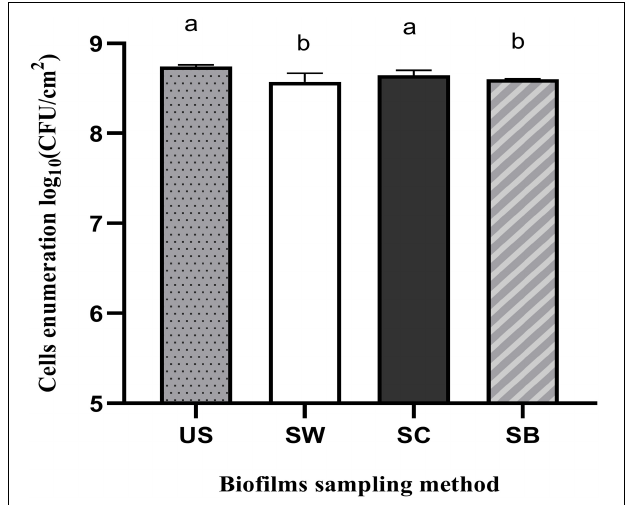
FIGURE 1 | Recovery of Pseudomonas azotoformans PFl1A cells from biofilms grown on stainless steel slides using TSB medium by ultrasonication (US), swabbing (SW), scraping (SC), and sonic brushing (SB). Values are mean ± SD ( n = 3). Significant differences (different letters, p < 0.05) are based on one-way ANOVA and Dunnett’s multiple comparison